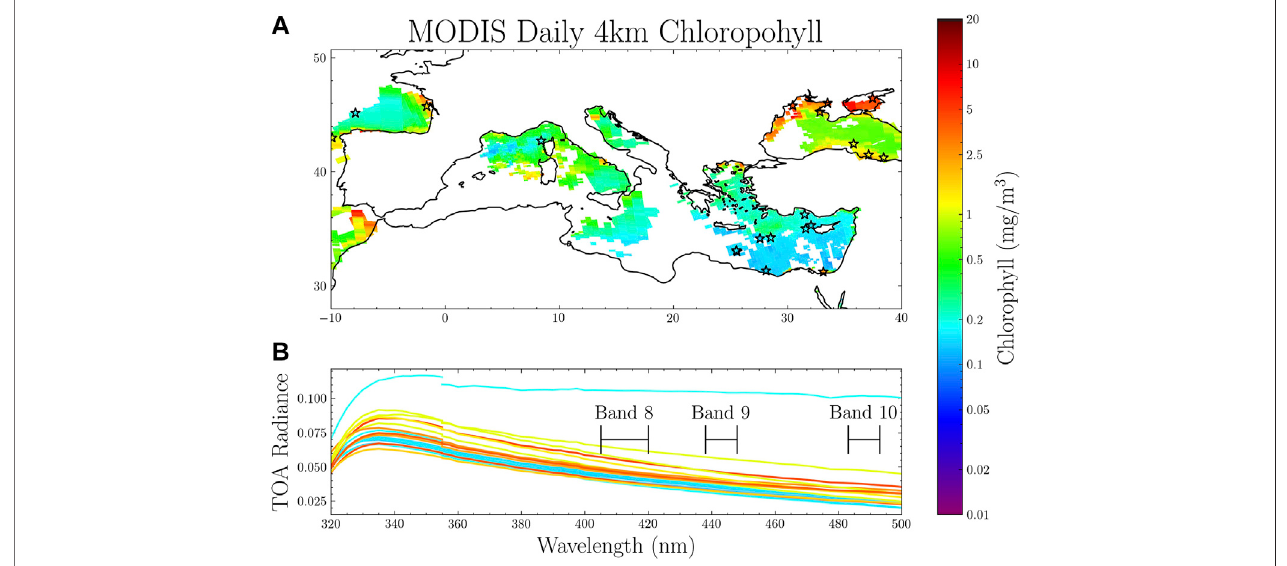
FIGURE1| SatelliteobservationsovertheMediterraneanSeafrom15March2005. (A) MODISdaily4 kmchlorophyllconcentrationco-locatedtotheOMIFieldsof View (FoVs), stars correspond to radiances plotted in bottom; (B) cloud-free TOA radiances from OMI for several random locations plotted as a function of wavelength with the color representing the MODIS chlorophyll concentration. The lines on the plot represent the MODIS bands that are in OMI ’ s spectral range.